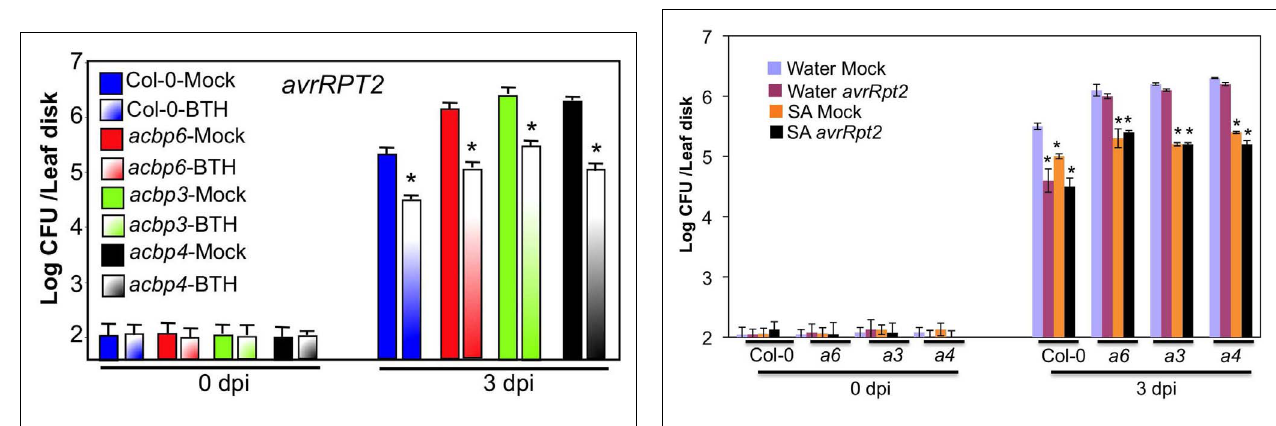
FIGUREA6 | Systemic acquired resistance response in Col-0 and acbp6 ( a6 ), acbp3 ( a3 ), acbp4 ( a4 ) plants, pretreated with water (blue and pink bars) or 50 µ M SA (orange and black bars) prior to infiltration with MgCl 2 (mock, blue, and orange bars) or P. syringae expressing avrRpt2 (pink and black bars). Bacterial growth presented as the LOG of colony forming units (CFU) per leaf disk, was monitored at 0 and 3dpi. Error bars indicate SD ( n = 4). Asterisks denote statistical differences from water + mock-inoculated plants (blue bars) of corresponding genotype, calculated using Student’s t -test ( P <